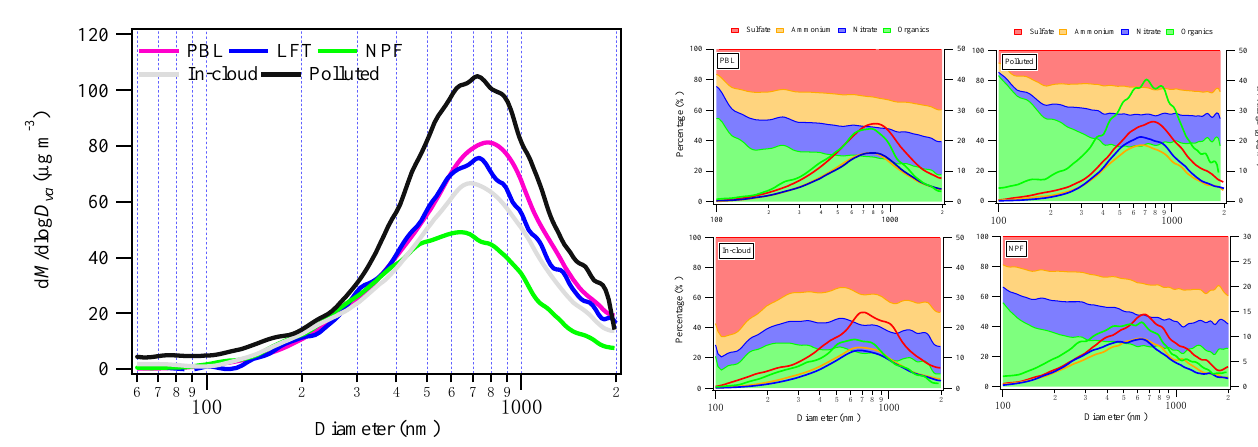
Figure 4. The MSDs of PM 1 in different episodes.